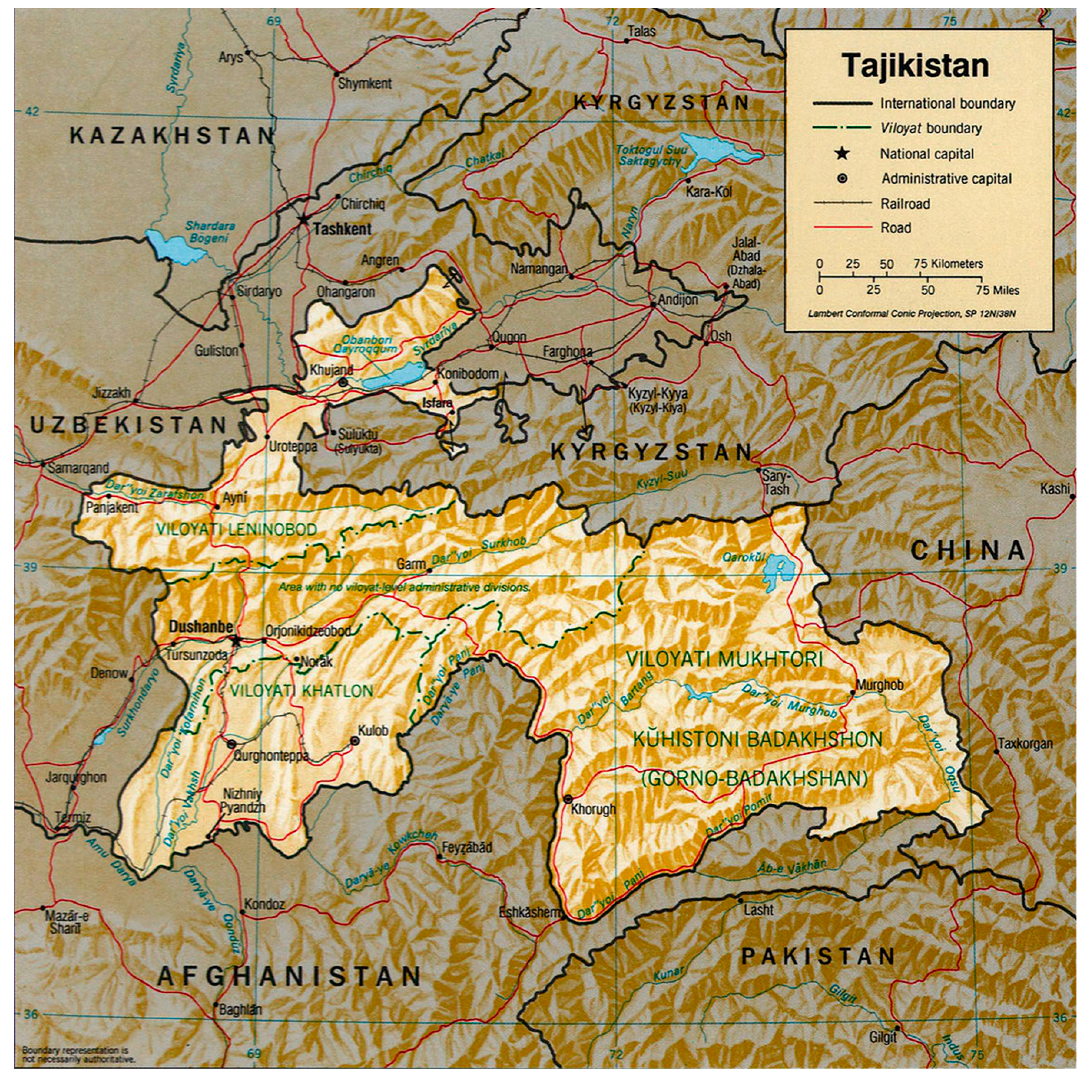
Figure 1. Geography of Tajikistan [7].